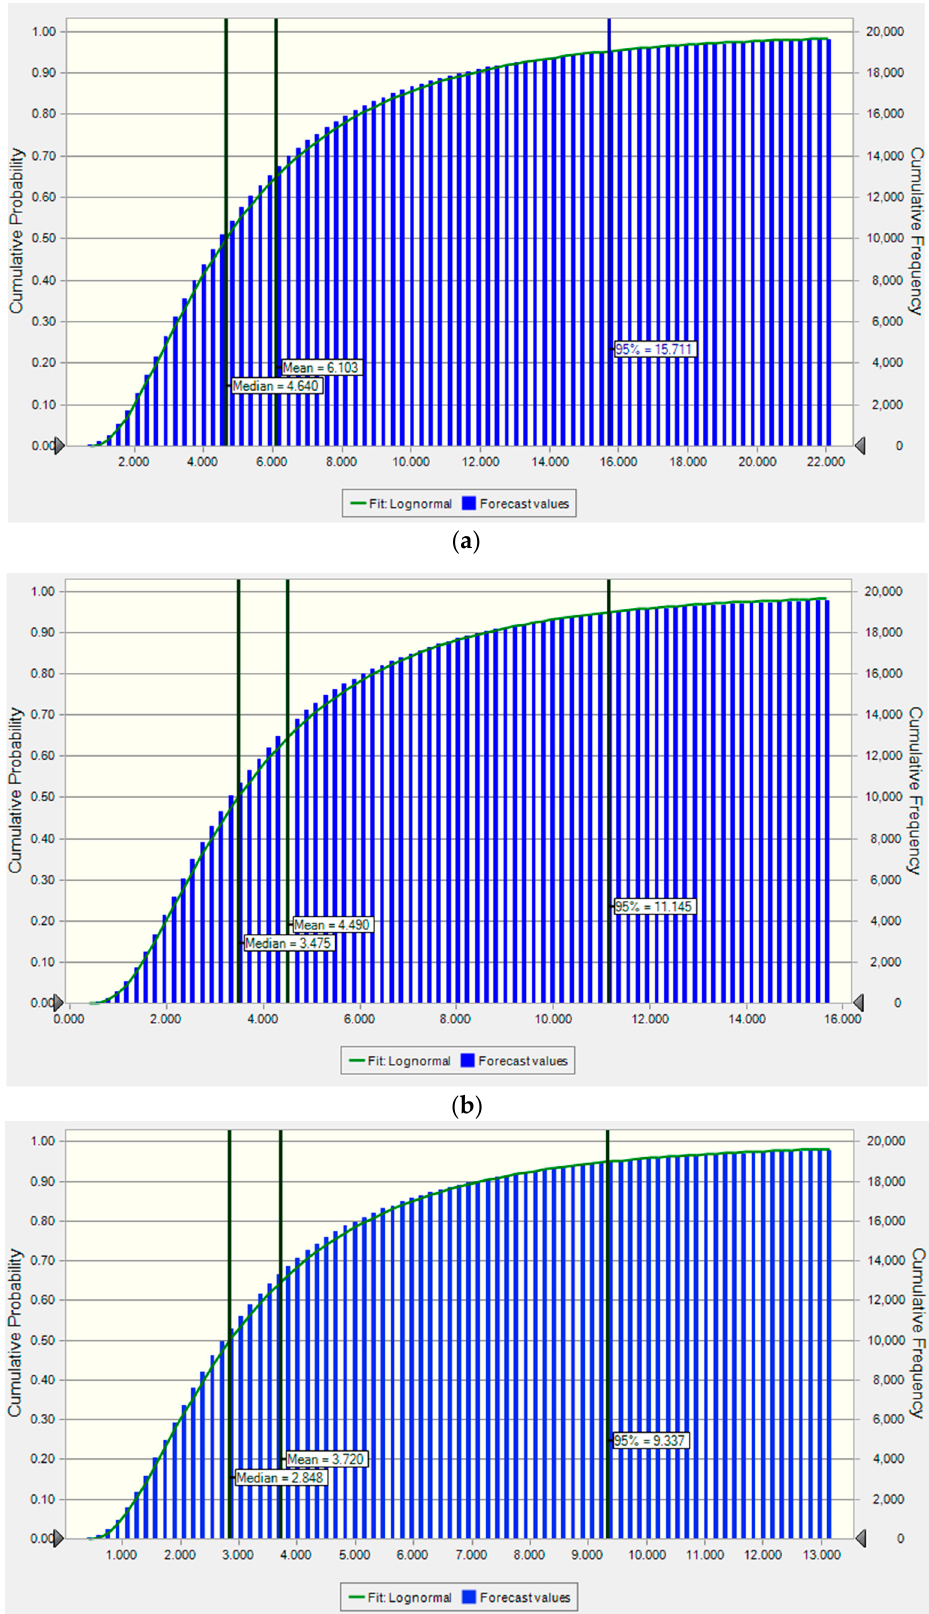
Figure 4. Cumulative distribution of the hazard indexes (HIs) of heavy metals for ( a ) children, ( b ) adolescents, and ( c ) adults.